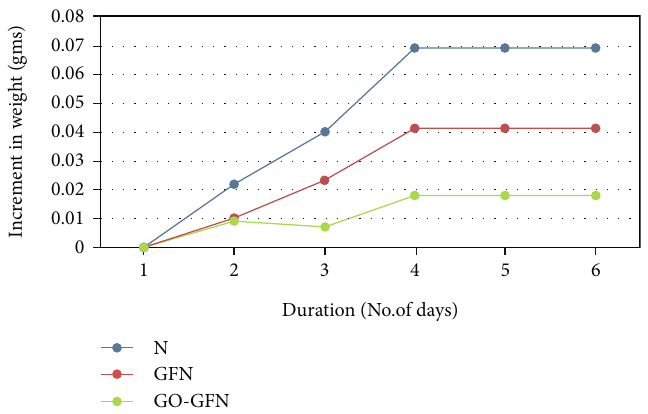
Figure 9: Water absorption of nylon, glass- fi lled nylon, graphene oxide-blended glass- fi lled